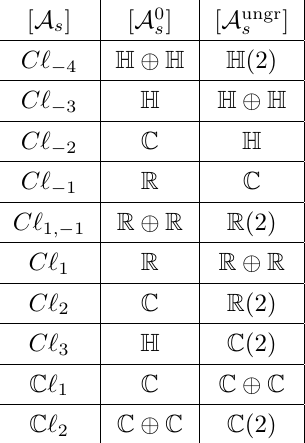
Table 2 . The set of distinguished Morita-classes of superalgebras appearing form φ -irreps. u 2 = − 1 , then D = H ⊗ H ∼ = R (4) . If u 2 = 1 , then D = H ⊗ R (2) ∼ = H (2) . Since we